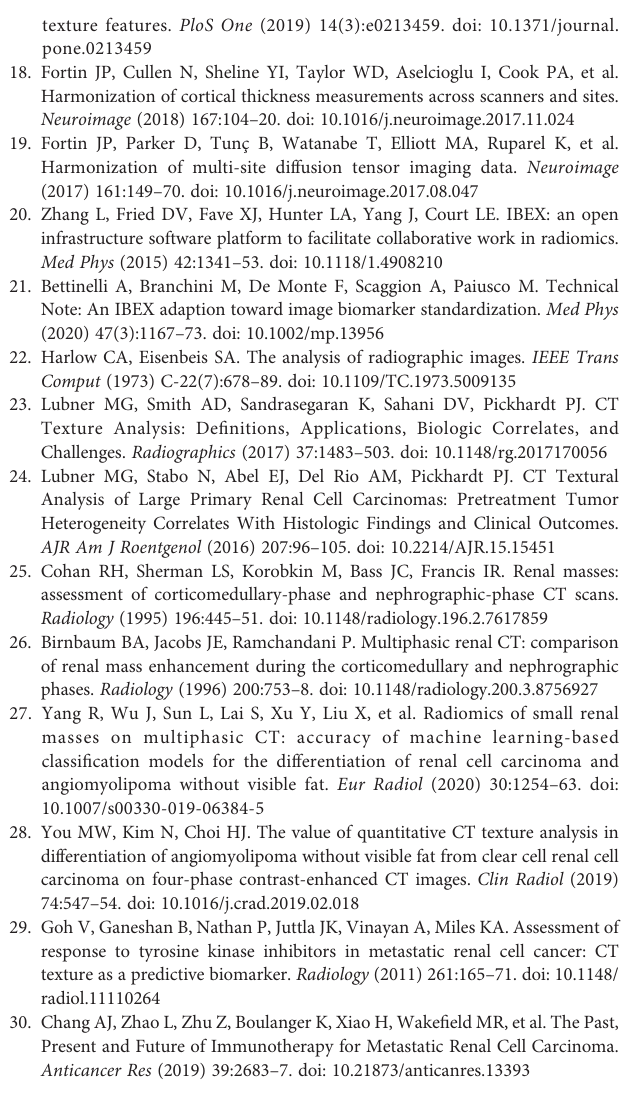
Supplementary Figure 1 | The inner correlation between radiomic features from the nephrographic phase and mRNA data. Nephrographic radiomic features and